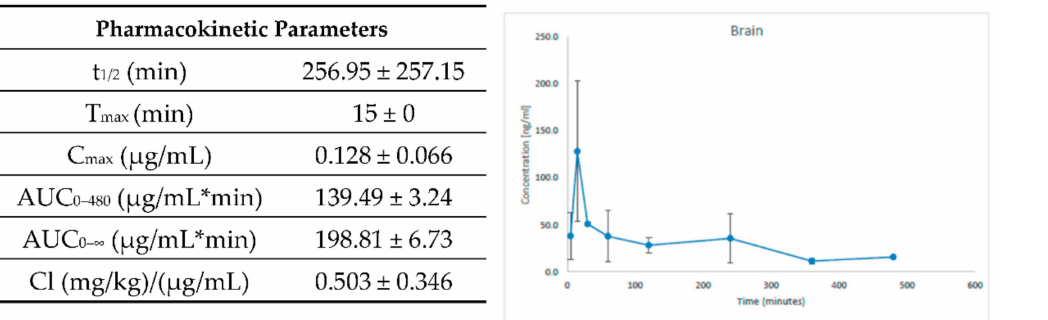
Figure 10. Brain concentration of B06 at different times (5 min–24 h) after intraperitoneal administra- tion of 10 mg/kg. Basic PK parameters were calculated. C max : maximum observed concentration, T max : time of maximum observed concentration, t 1/2 : terminal elimination half-life, AUC 0–1440 : area under the curve from zero to the last sampling time, AUC 0– ∞ : area under the curve from zero extrapolated to infinity and Cl: the brain